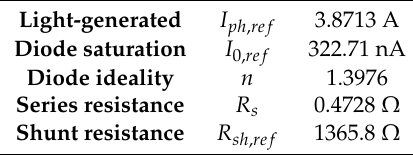
Table 2. BPMSX-120